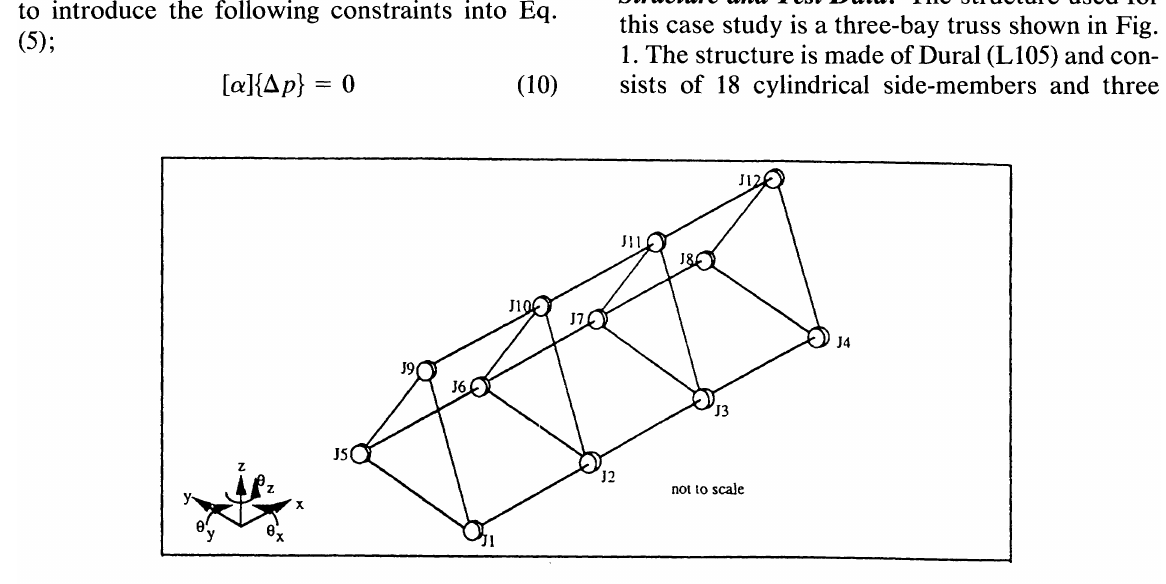
FIGURE 1 The truss structure used in case study